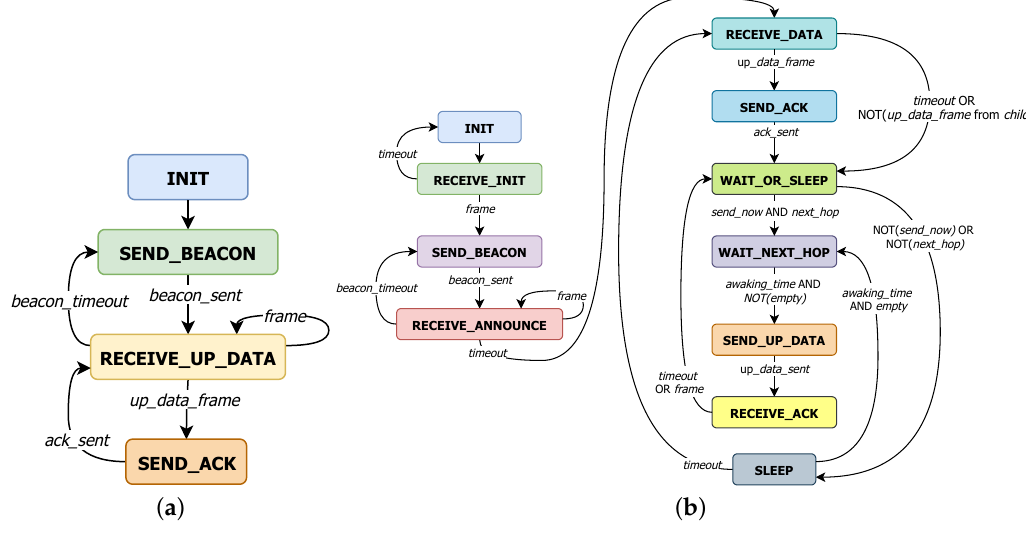
Figure 2. Finite State Machine ( a ) Gateway ( b )